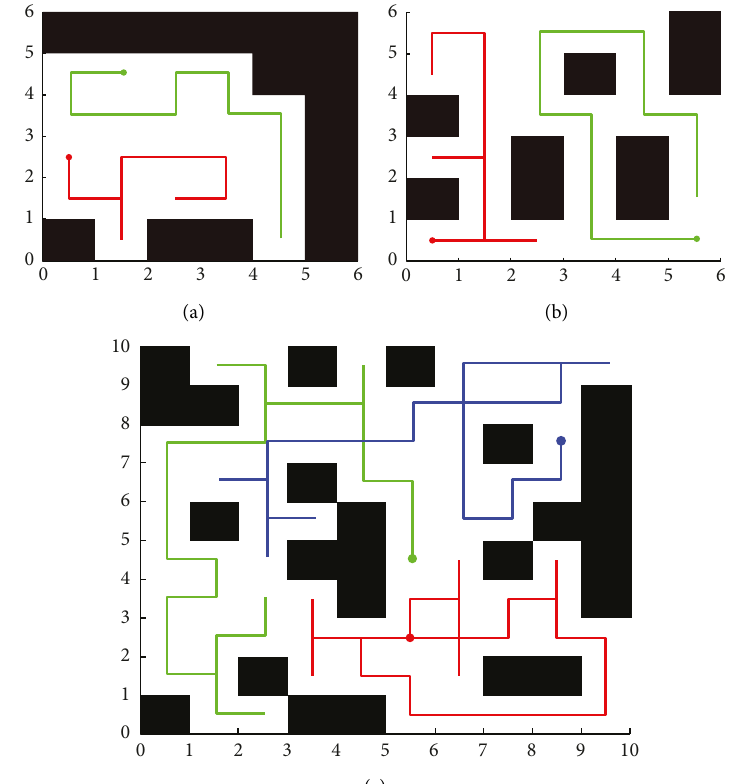
Figure 10: A set of results of different environmental sizes. (a) Smaller environment than training size. (b) Normal size environment. (c) Wider environment than training